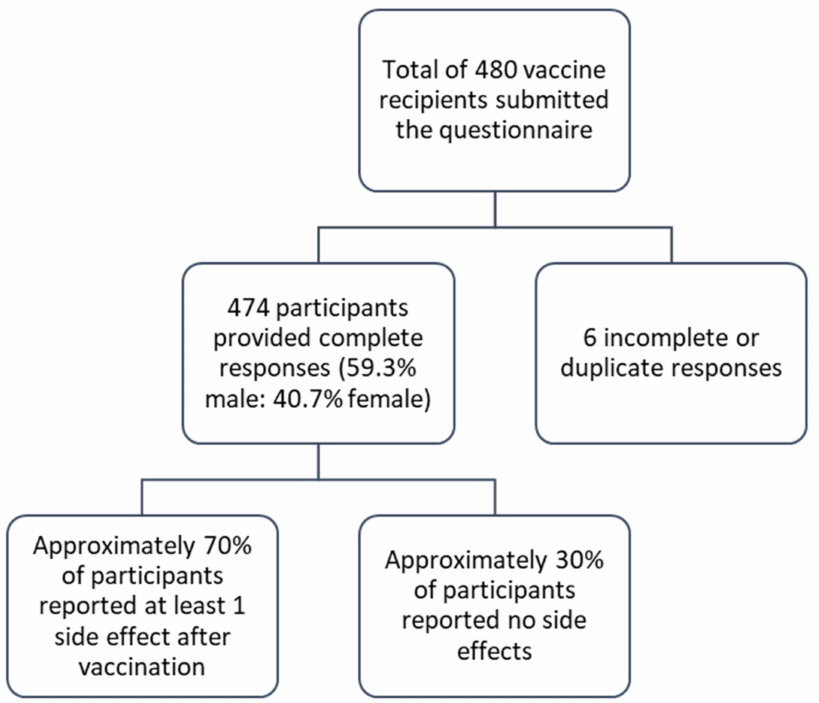
Figure 1. Flowchart showing the survey responses of the Covishield vaccine